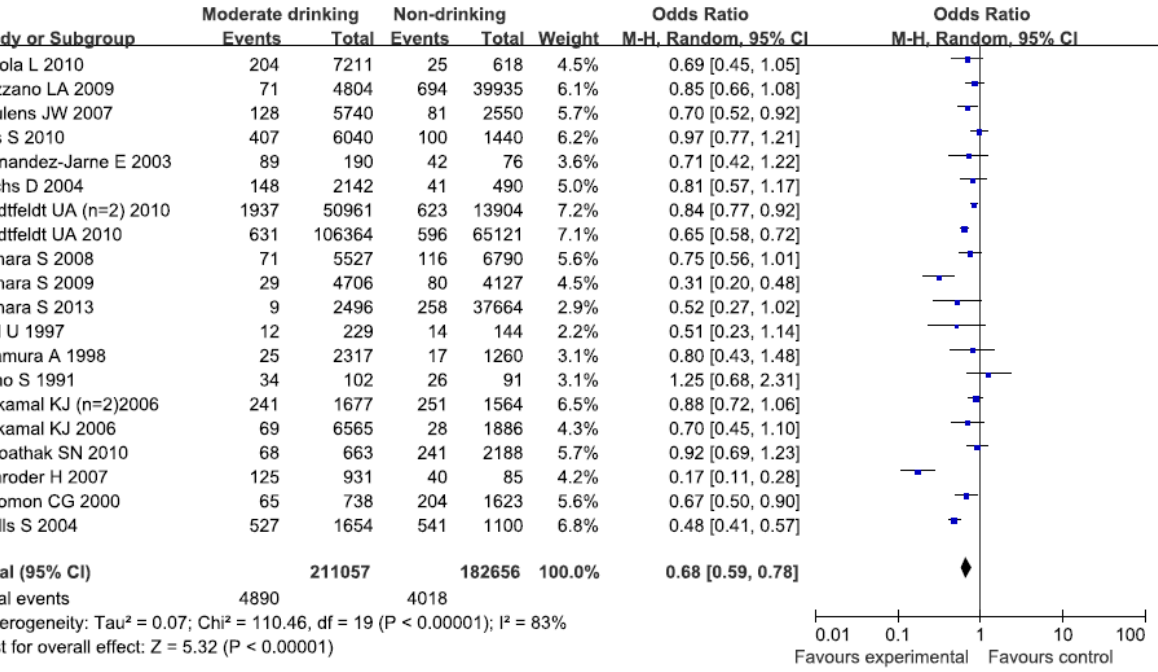
Figure 4. Forest plot of the moderate drinking compared with the non-drinking category of intake the alcohol-drinking pattern and CHD risk.